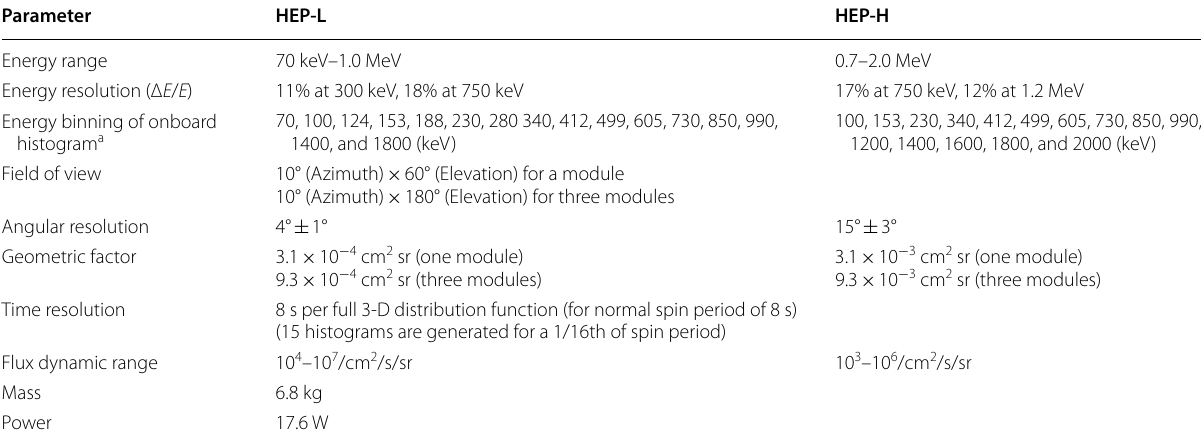
a Hatched values are for calibration purposes. All values can be changed as onboard software parameters with commands issued from the